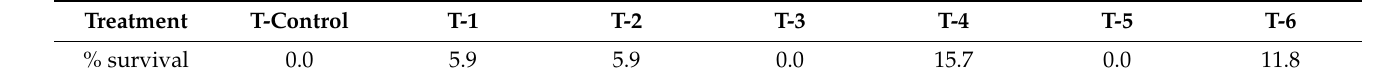
Table 2. The % C. juncea survival in all the treatments (1–6 and control). Treatment